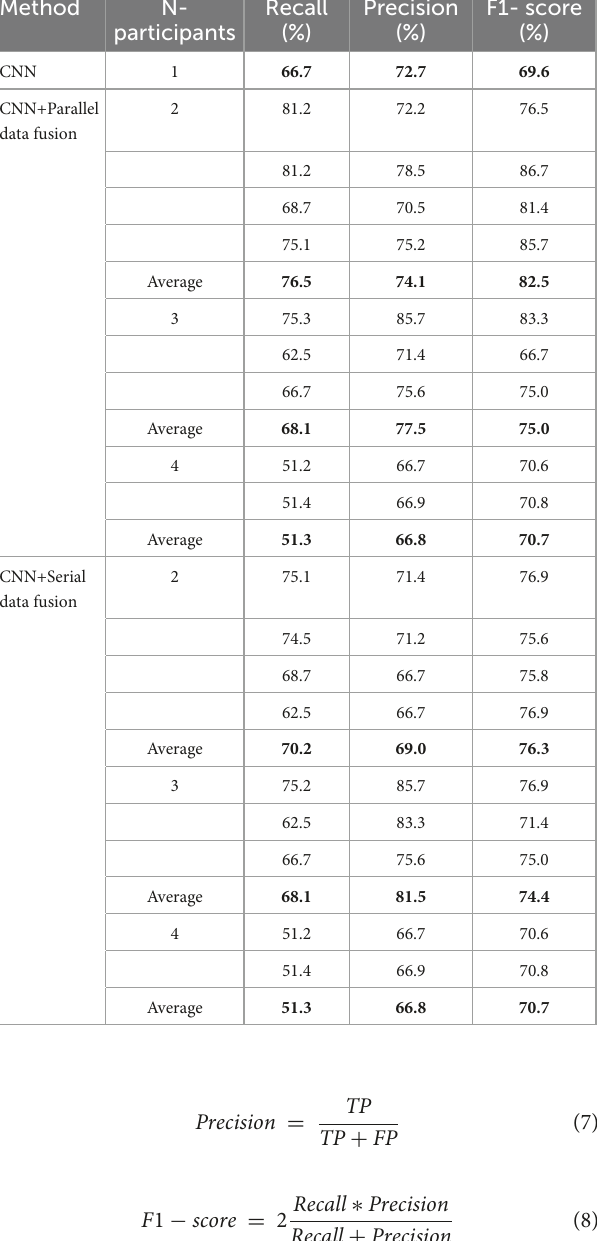
TABLE 4 Single-trial P300 classification results of a centralized multi-person data fusion convolutional neural network (CNN) for different numbers of